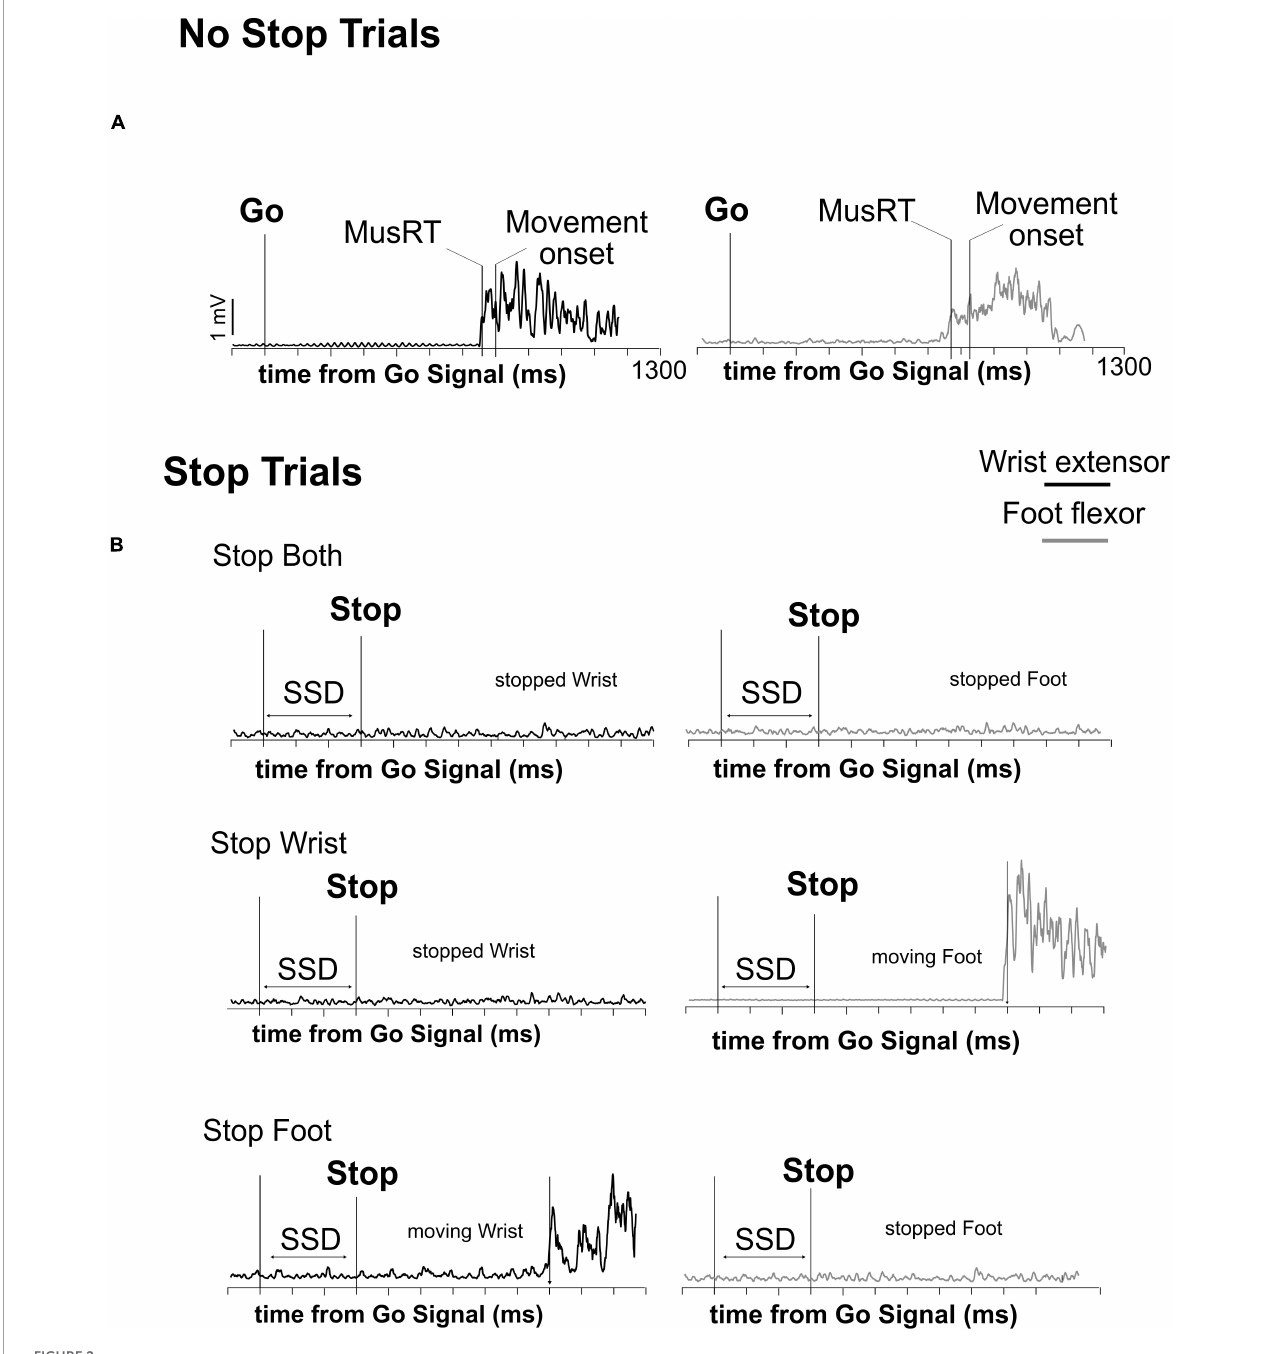
FIGURE2 Time evolution of muscular activity (EMG) in the different trial types. Activation’s profile of agonist muscles activity of wrist and foot in a single correct No Stop trial (A) and Stop trials (B) during the execution of the three versions of the multi-effector selective SST. The onset of muscle activity (MusRT) and the behavioral response (Movement onset) are indicated in panel (A) . In panel (B) only MusRT is